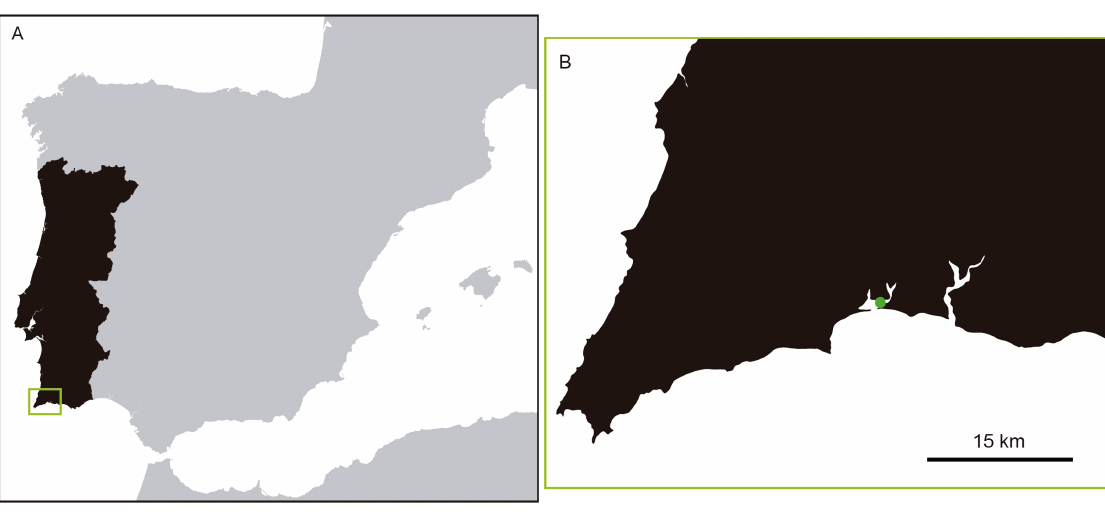
Fig. 1. A . Map showing the sampling area of Alvor (Faro, Portugal). B . Close-up of the sampling area. Green point marks the sampling